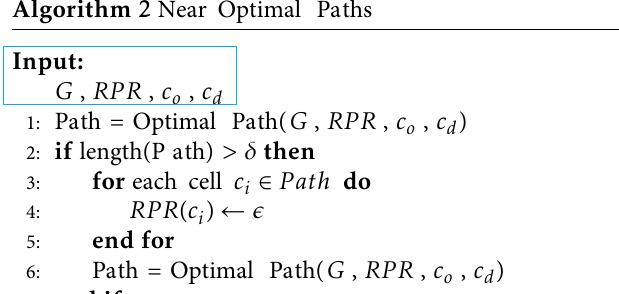
Algorithm 2 Near Optimal